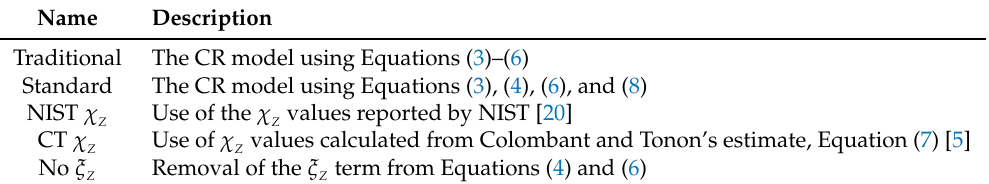
Table 1. A list of the terms used to describe the model and parameter configurations used throughout this work, along with a brief description of